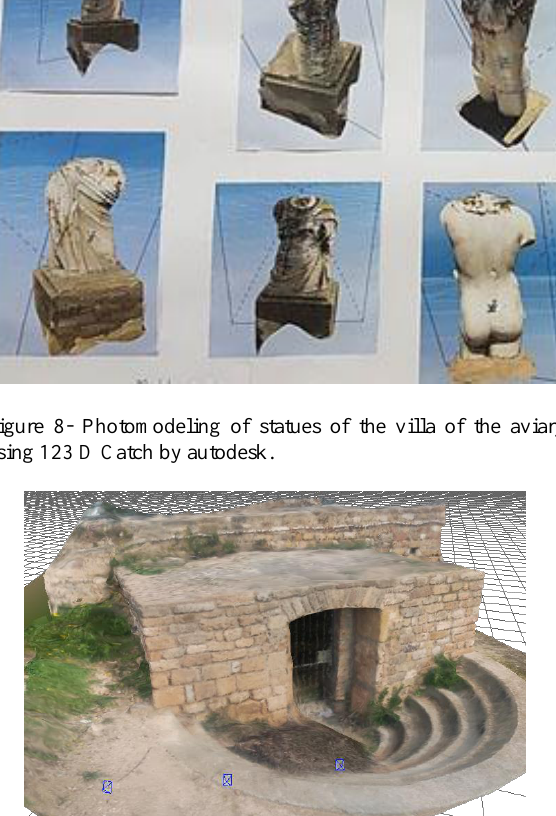
Figure 6- Photomodelling of a statue in the site museum of Carthage using Scann 3D.